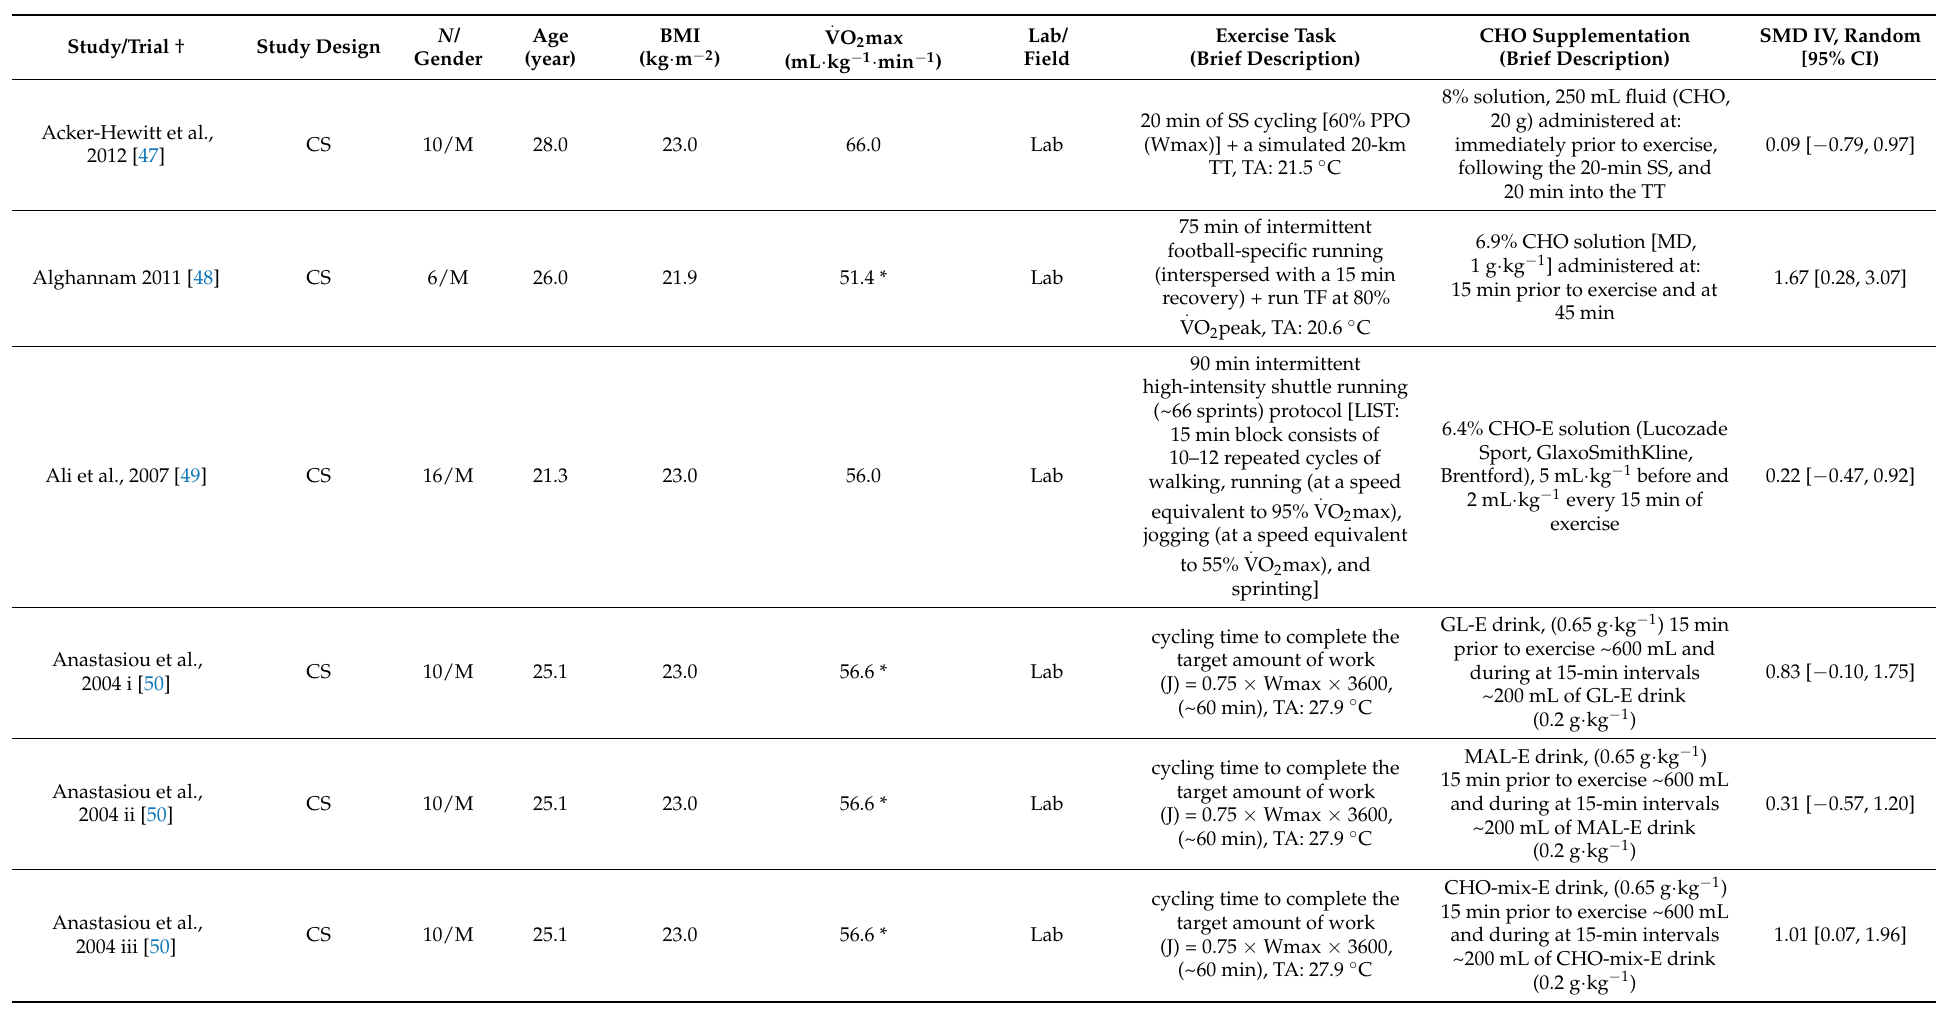
Table 1. Overview of the reviewed articles and the effect of experimental carbohydrate supplementation as compared to a control on an exercise task in SMD with 95% CI. Data presented as mean or range or otherwise stated. Where not reported in the articles, sufficient averaged data per sex subgroups and averaged pooled values for mixed sample groups are referred to,